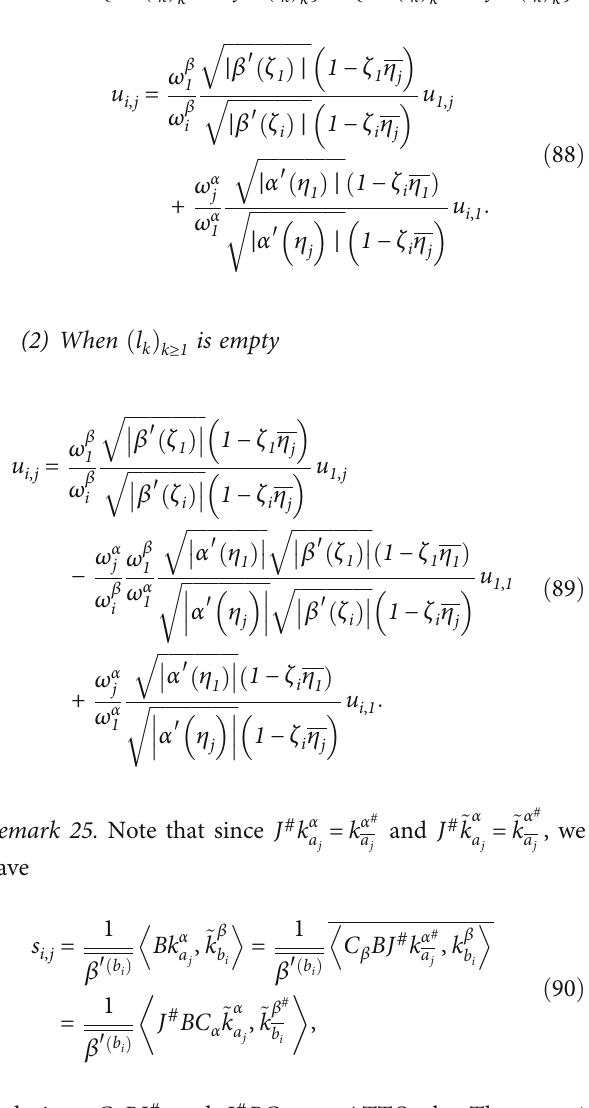
ffiffiffiffiffiffiffiffiffiffiffiffiffiffiffiffi (cid:12) β ′ ζ ð Þ (cid:12) 1 ffiffiffiffiffiffiffiffiffiffiffiffiffiffiffi (cid:12) β ′ ζ ð Þ (cid:12) i ffiffiffiffiffiffiffiffiffiffiffiffiffiffiffi (cid:12) α ′ η ð Þ (cid:12) i ffiffiffiffiffiffiffiffiffiffiffiffiffiffiffiffiffi (cid:3) (cid:4)(cid:12) α ′ η (cid:12) (cid:12) j